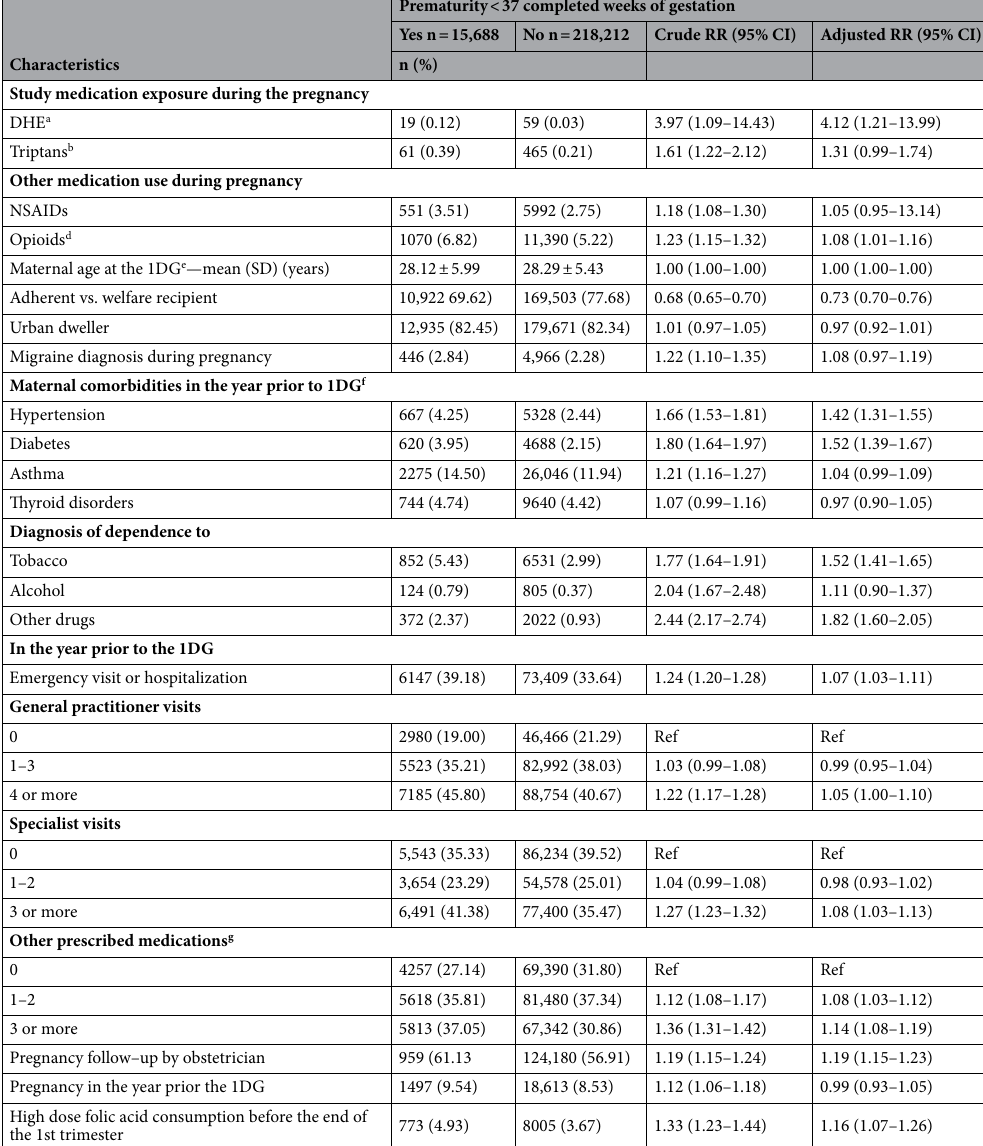
zolmitriptan; c Including celecoxib, diclofenac, diflunisal, etodolac, fenoprophen, fentanyl, flurbiprofene, hydrocodone, hydromorphone, ibuprofen, indomethacin, ketoprofen, mefenamic acid, meloxicam, nabumetone, naproxen, piroxicam, rofecoxib, sulindac, tiaprofenic acid, tolmetin, and valdecoxib; d Including codeine, meperidine, morphine, oxaprozin, oxycodone, oxymorphone, pentazocine, tapentadol, propoxyphen, and tramadol. Note: Pregnant women can use more than 1 study medication during pregnancy. e First day